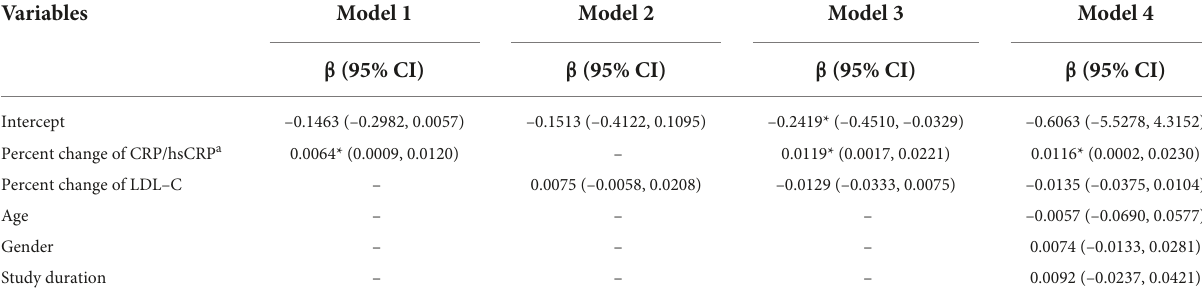
TABLE 2 Meta-regression analysis for SMD in change of